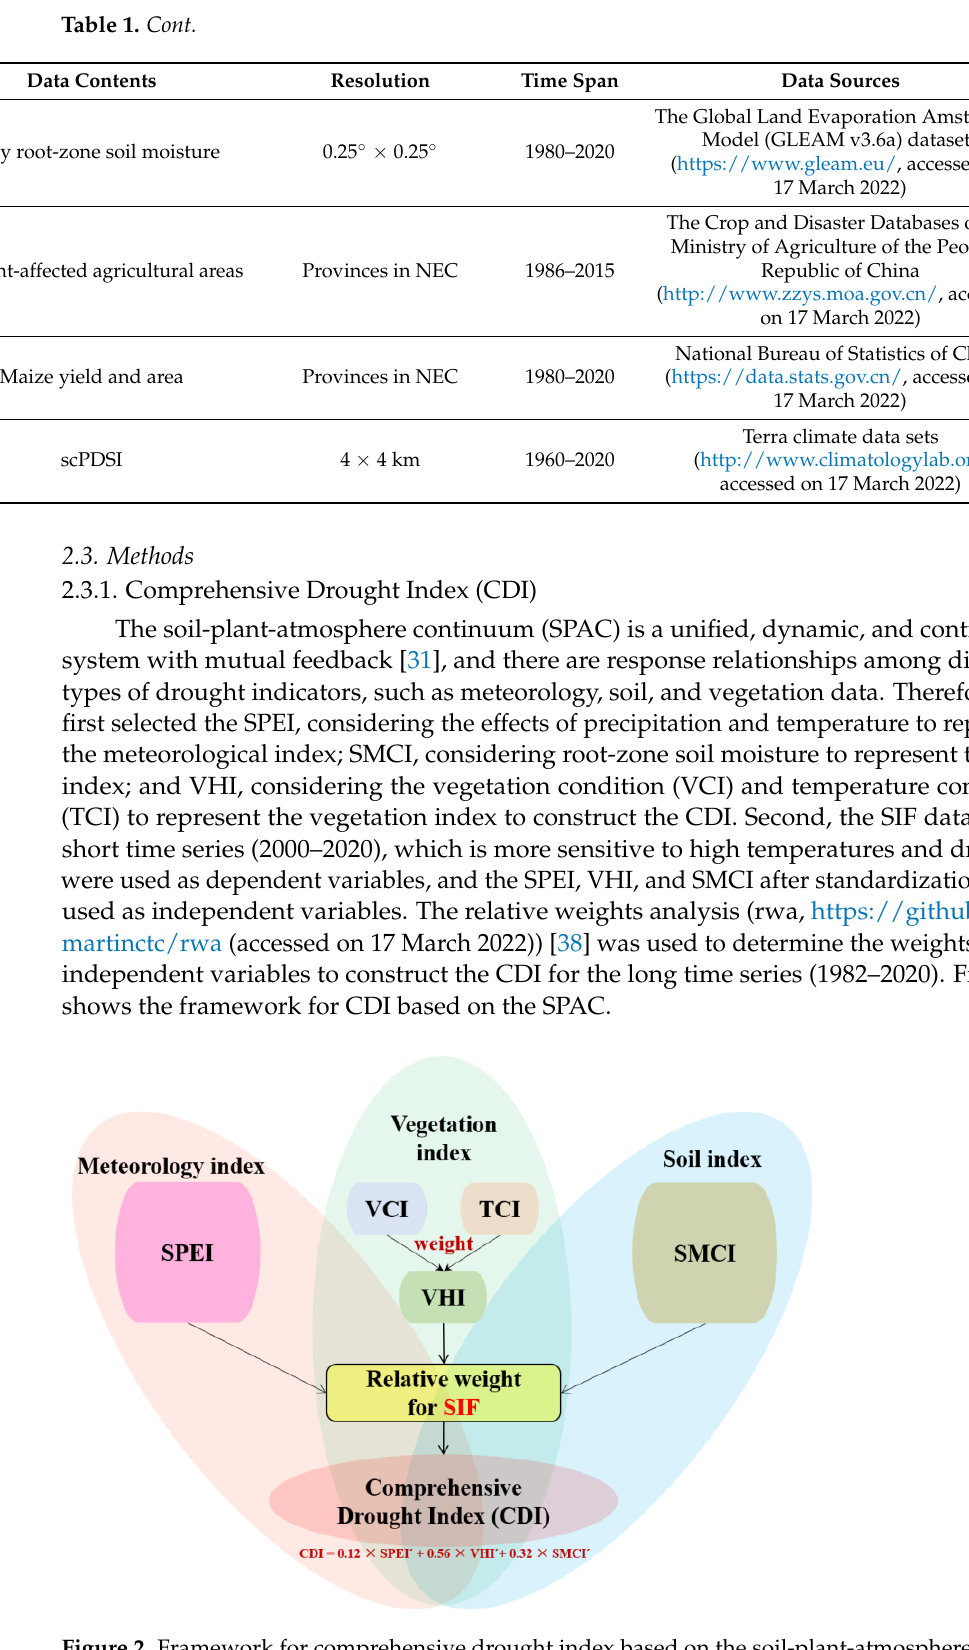
Figure 2. Framework for comprehensive drought index based on the soil-plant-atmosphere contin- uum (SPAC).